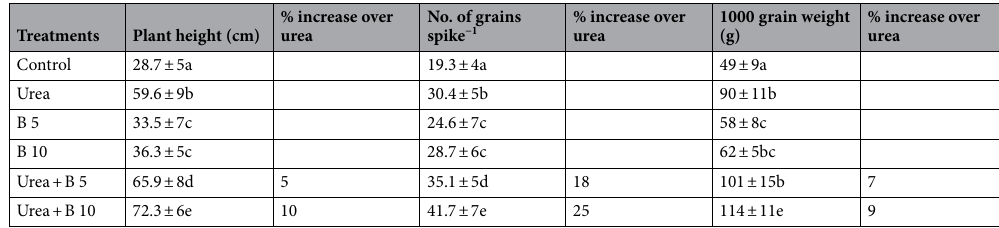
Table 3. Plant height (cm), number of grains spike -1 , 1000 grain weight (g) in soils amended with sole urea or urea + biochar treatments. Values within a column followed by the same letter are not-significantly different at P < 0.05.